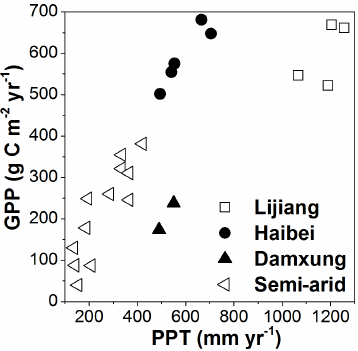
Figure 10. Relationships between the annual GPP and precipitation (PPT) for this Lijiang site, the Haibei site (Kato et al., 2006; Fu et al., 2009), the Damxung site (Fu et al., 2009) and the semi-arid grassland sites (Fu et al., 2009; Du and Liu, 2013; Yang and Zhou,